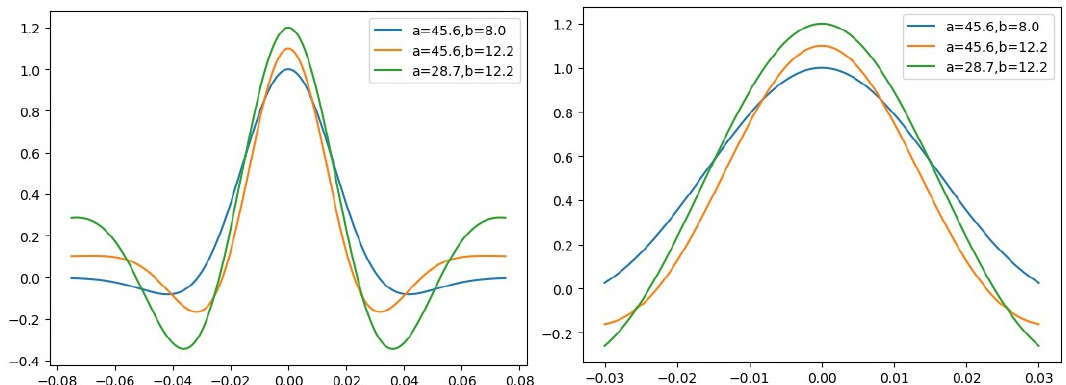
Figure 1. Kernels of time-frequency convolutional units with the same parameters for different sample rate (250 Hz for left and 100 Hz for right ),